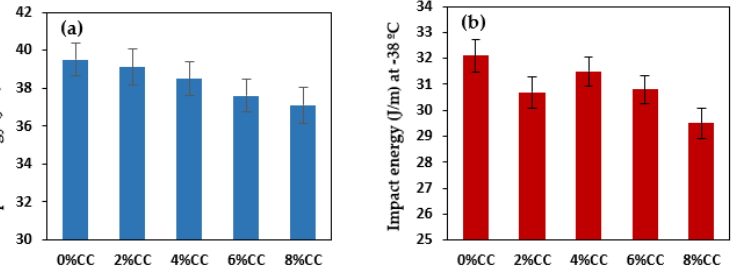
Figure 10. Effect of filler loadings on the Charpy impact energy of the 3D printed specimens at: ( a ) 22 °C; and ( b ) − 38 °C.